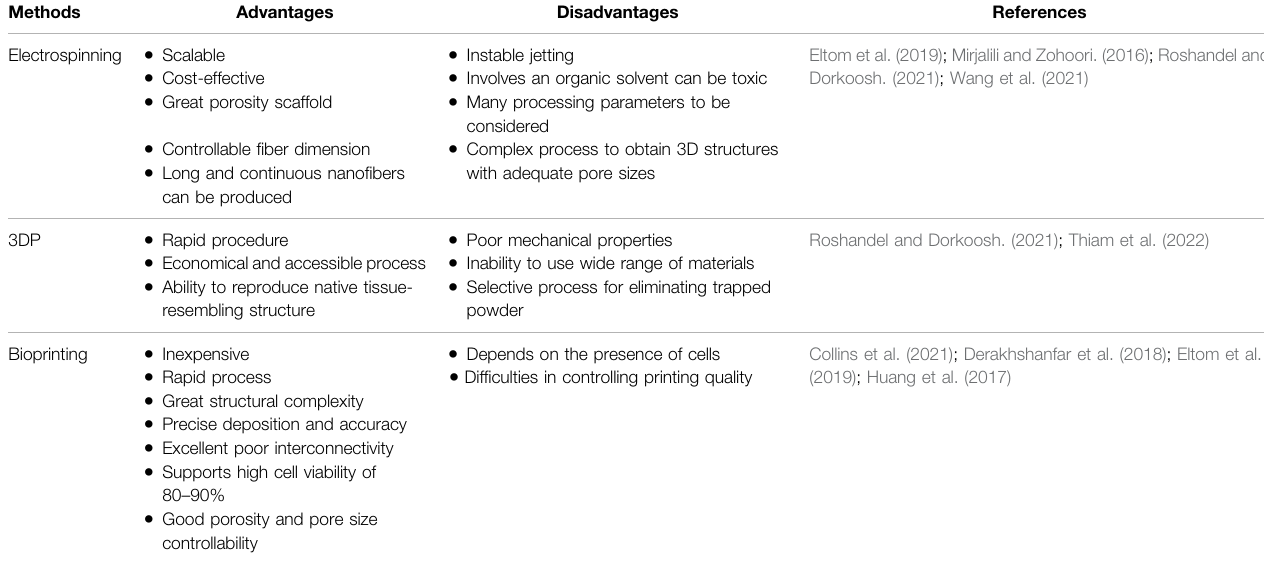
TABLE 3 | The advantages and disadvantages of each fabricating